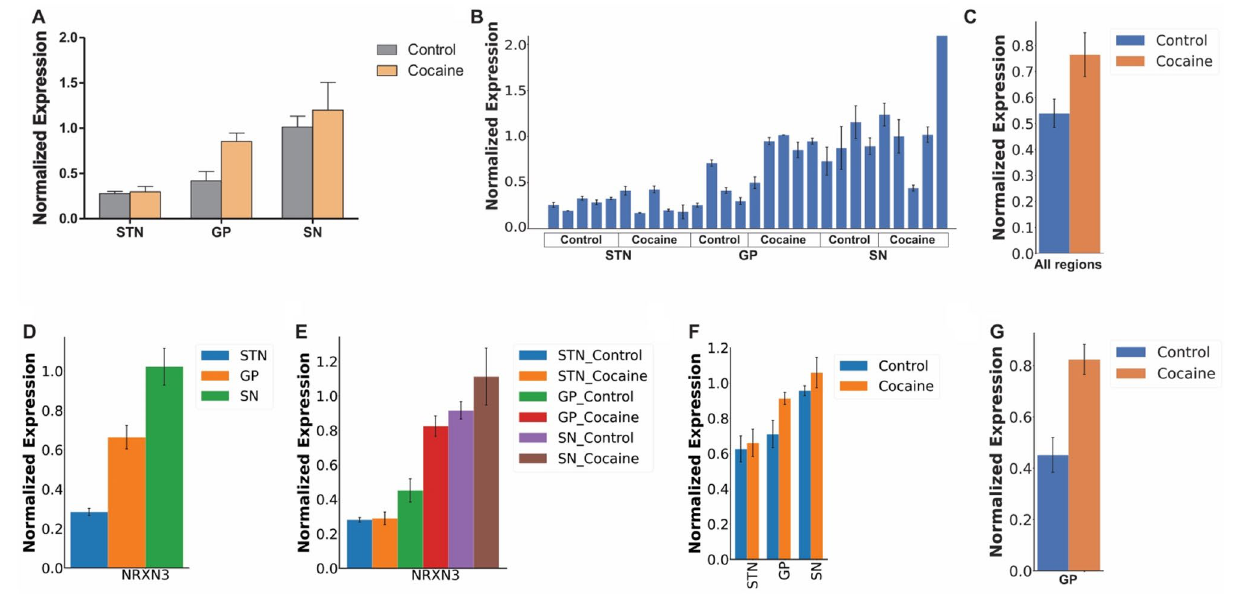
Figure 5. Auto-qPCR can process data from different thermocyclers and produce the same results as manual processing. ( A ) Bar chart showing the mean Nrxn3 expression level normalized to B2M levels assessed with an absolute quantification design manually processed and plotted in Prism, grouped by brain regions (STN: subthalamic nucleus, GP: globus paladus, SN: substantia nigra) on the x-axis, with and without cocaine treatment. ( B ) Output of Auto-qPCR processing the same dataset. Nrxn3 normalized expression levels from technical replicates for each biological sample. The treatment conditions are indicated below the x-axis. ( C ) Statistics output of Auto-qPCR program comparing cocaine and control groups. Nrxn3 normalized expression levels in the combined brain regions. Expression is not significantly different, p = 0.113, t test, n = 13. ( D ) Auto- qPCR statistical output showing mean Nrxn3 expression combining treatments and comparing the three brain regions. One-way ANOVA shows significant effect of brain regions, FDR adjusted p < 0.001, n = 9 for GP and SN, n = 10 STN. ( E ) Bar chart of Nrxn3 expression shown as six groups distinguished by brain region and treatment generated by Auto-qPCR program after a one-way ANOVA, p < 0.001, n = 4 or 5. Post hoc analysis using multiple t test with FDR correction comparing treatment at each brain region: SNT p = 0.990, GP p = 0.033, SN p = 0.413. ( F ) Bar chart of Nrxn3 average normalized by brain region (x-axis) and treatment, generated by Auto-qPCR program after a two-way ANOVA, brain region p < 0.001, treatment p = 0.2265, n = 4 or 5. Post hoc analysis using multiple t test with FDR correction comparing each brain region with and without cocaine: SNT p = 0.0.998, GP p = 0.053 and p-unadjusted = 0.017, SN p = 0.619 ( G ) Bar chart of the average Nrxn3 normalized expression levels in the GP compared between the two groups with a t test (p =